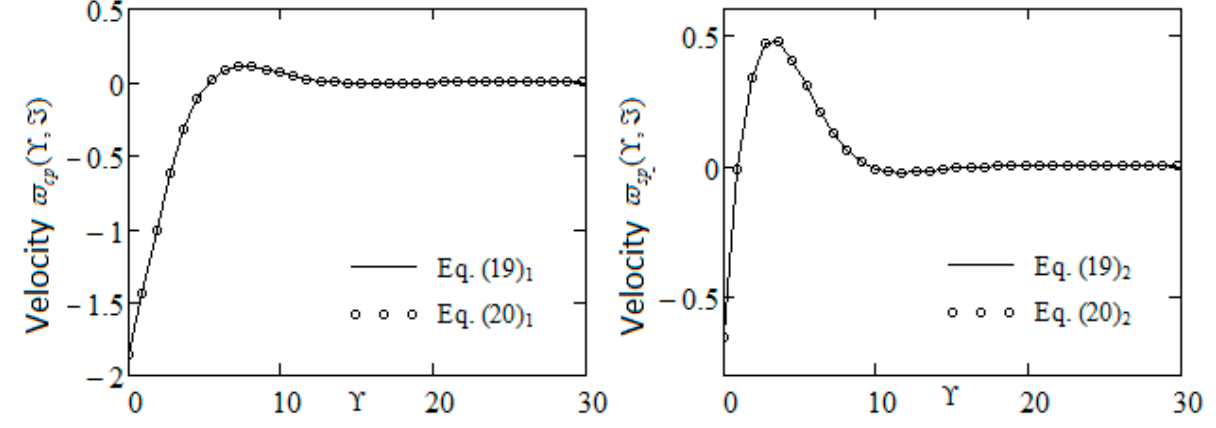
Figure 1. Profiles of ( , ) and ( , ) given by Equations (19) 1 and (20) 1 , respectively, (19) 2 and (20) 2 for α = 0.8, β = 0.7, γ = 0.6, ω = π /12 and J = 5.